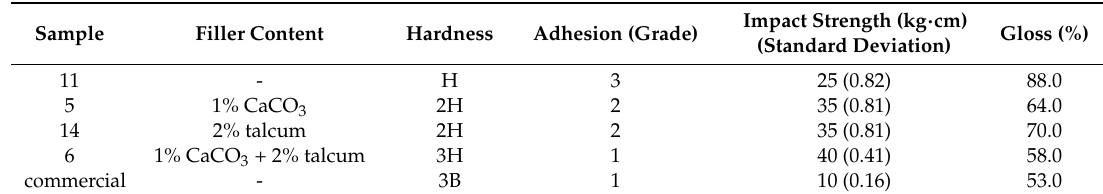
Table 8. Performance comparison of WUVCW with talcum modification.